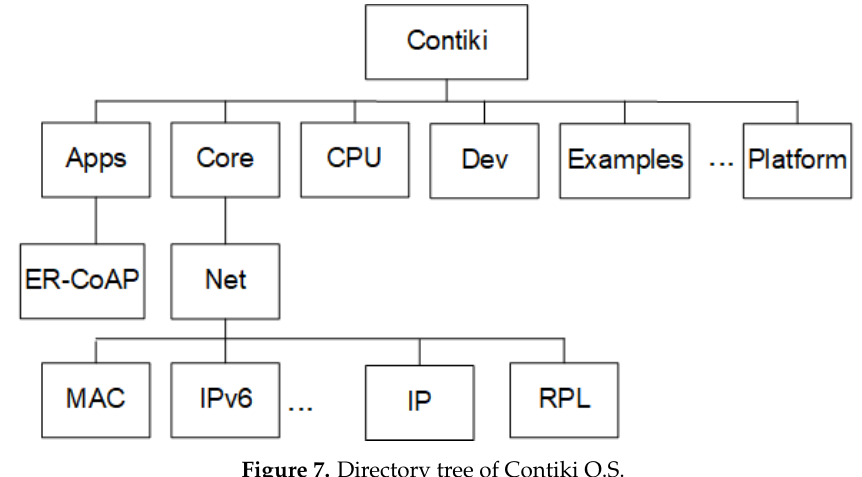
Figure 7. Directory tree of Contiki